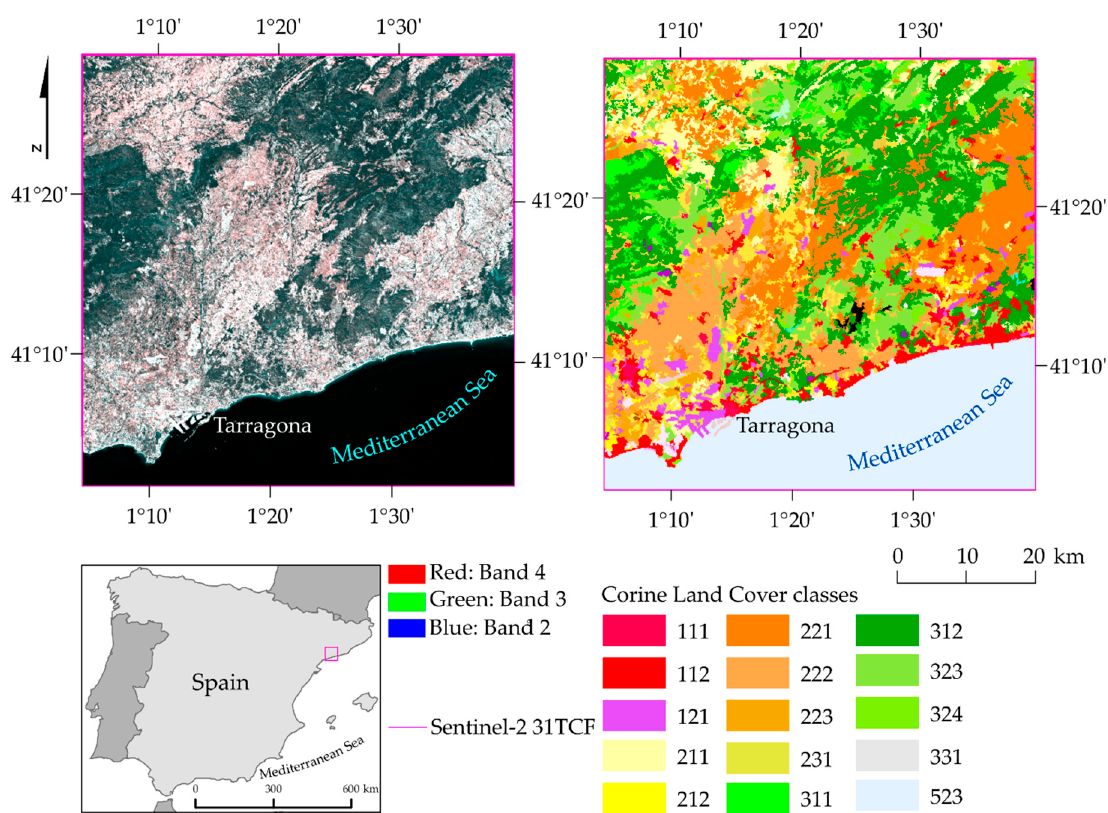
Figure 2. Location of Tarragona, Catalan area (source: own study based on Sentinel-2 images, ESA, 2018 and the Corine LC map of the European Environment Agency, 2018). Codes: 111: continuous urban fabric; 112: discontinuous urban fab-